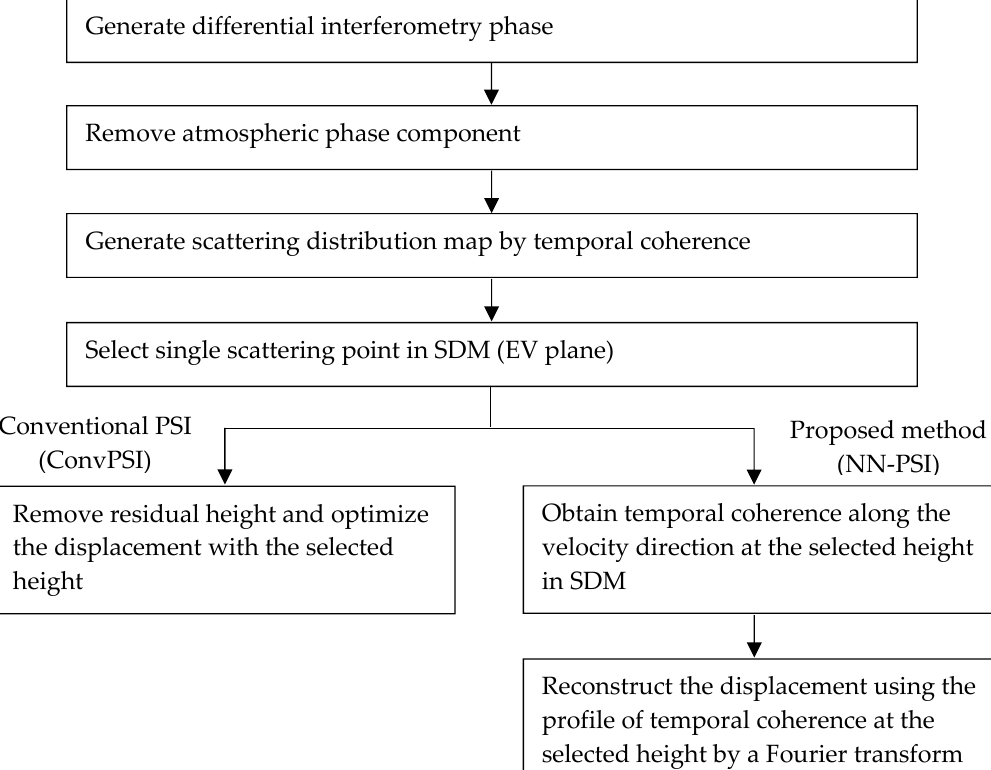
Figure 2. Process flows of the conventional persistent scatterer interferometry (PSI) and the proposed method.